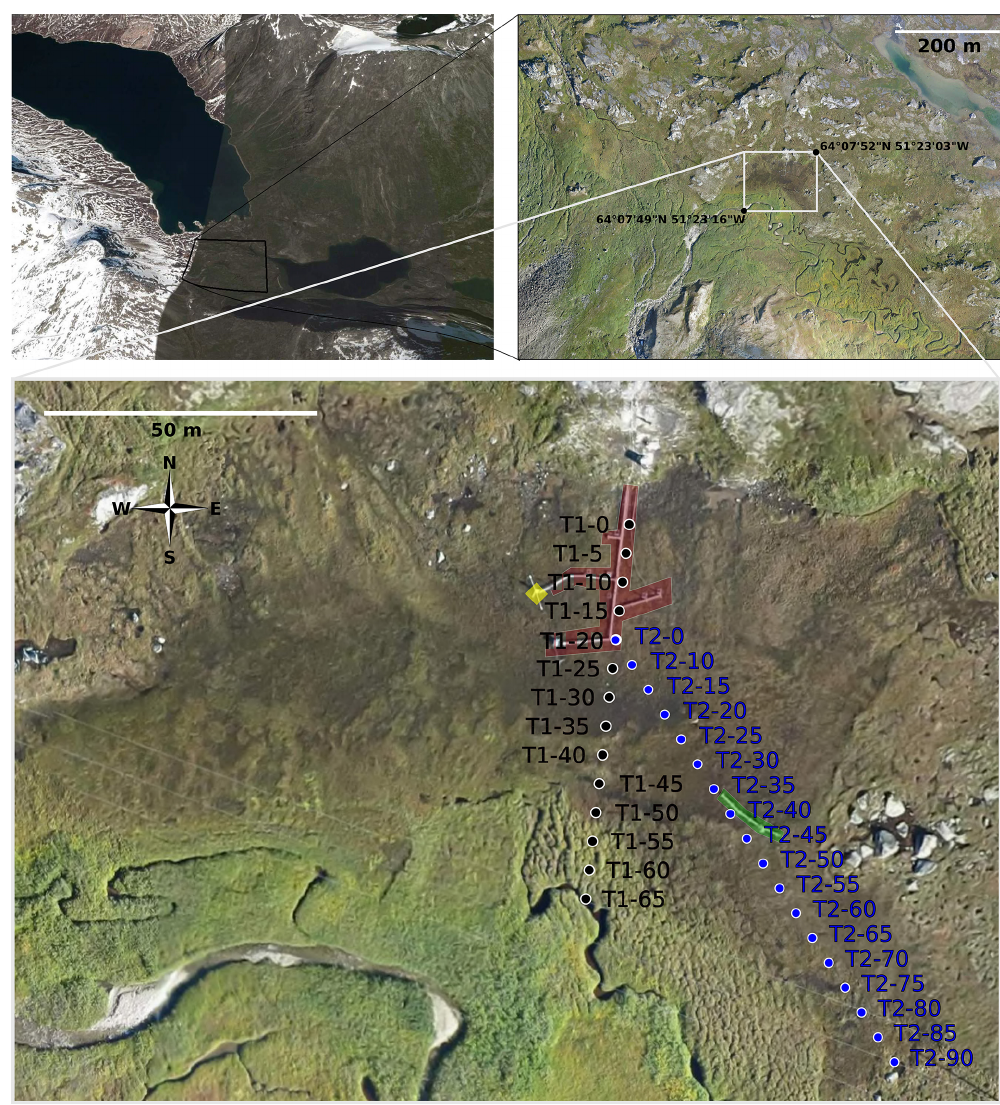
Figure 1. Left top panel: satellite image (© Google Earth – 2009) of Kobbefjord, centered on 64 ◦ 7 (cid:48) 51.5 (cid:48)(cid:48) N, 51 ◦ 23 (cid:48) 10.5 (cid:48)(cid:48) W. Right top panel: high-resolution photography (taken by a drone in 2015) of the valley floor. The white rectangle surrounds the fen. The bottom panel shows a zoom of the fen, with the two studied transects: T1 (black circles) and T2 (blue circles). Zones highlighted in red represent the location of the automatic chambers, in green the soil temperature probes, and in yellow the eddy flux